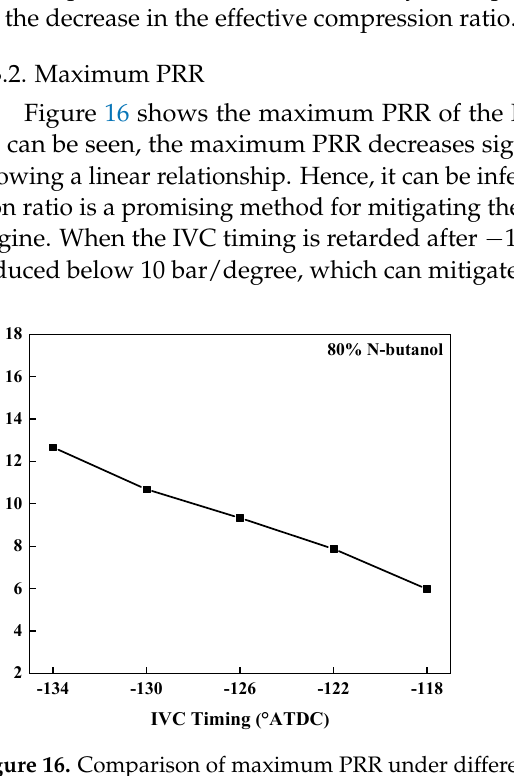
Figure 16. Comparison of maximum PRR under different IVC timings.